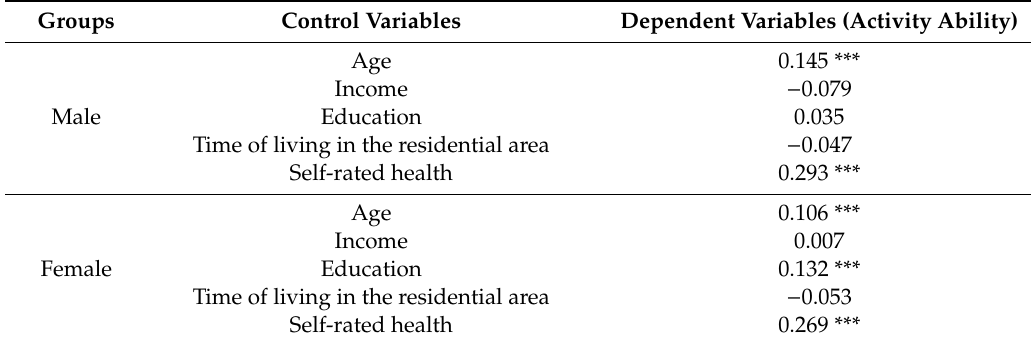
Table 4. E ff ect of control